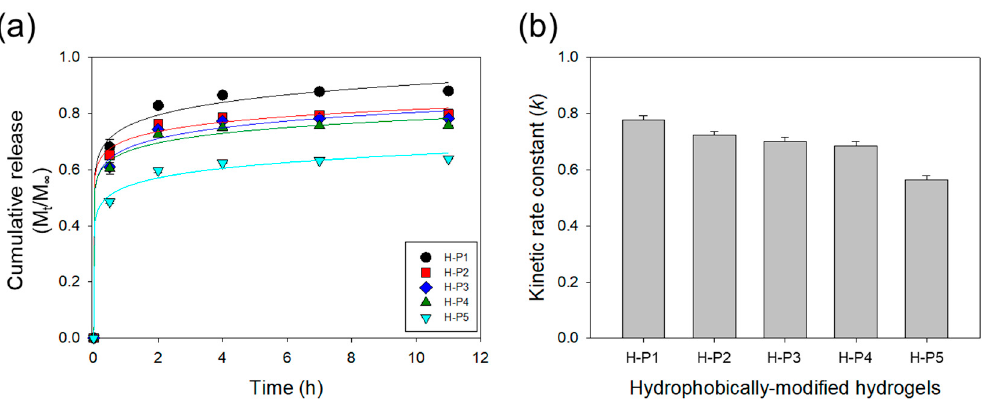
Figure 5. ( a ) Cumulative release profiles of bovine serum albumin (BSA) from the hydrogels. The solid lines represent the fitting curves used to quantify the kinetic rate constant ( k ) of release presented in ( b ).